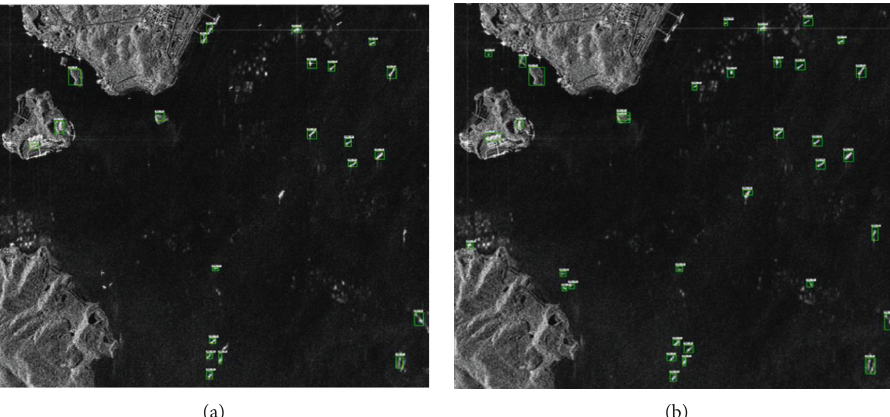
Figure 20: The detection results of different methods on the large-scene image II. (a) The original Faster RCNN method. (b) The proposed detection method.